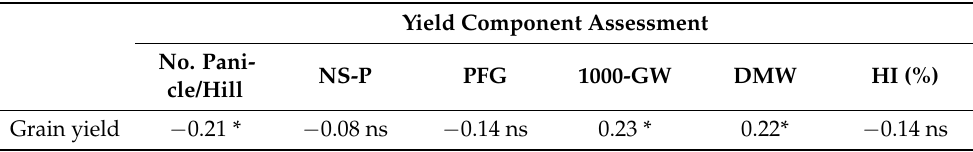
Table 8. Correlations of the yield components, dry matter weight, and harvest index of all assessed parameters with the grain yield. Yield Component Assessment No. Pani- NS-P PFG HI (%) cle/Hill Grain yield − 0.21